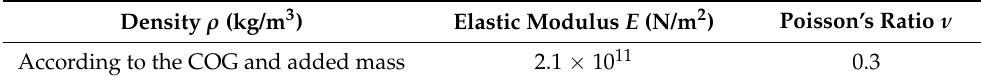
Table 5. The elastoplastic material